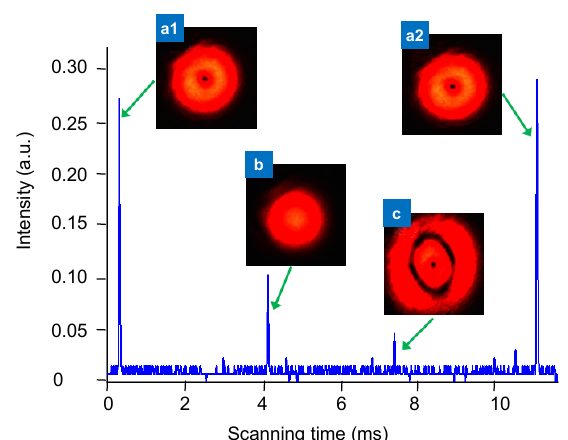
Fig. 5 | The transmitted curve of a 50% blocked LG 01 beam obtained from the scanning FP cavity and the intensity distributions of each main peak.